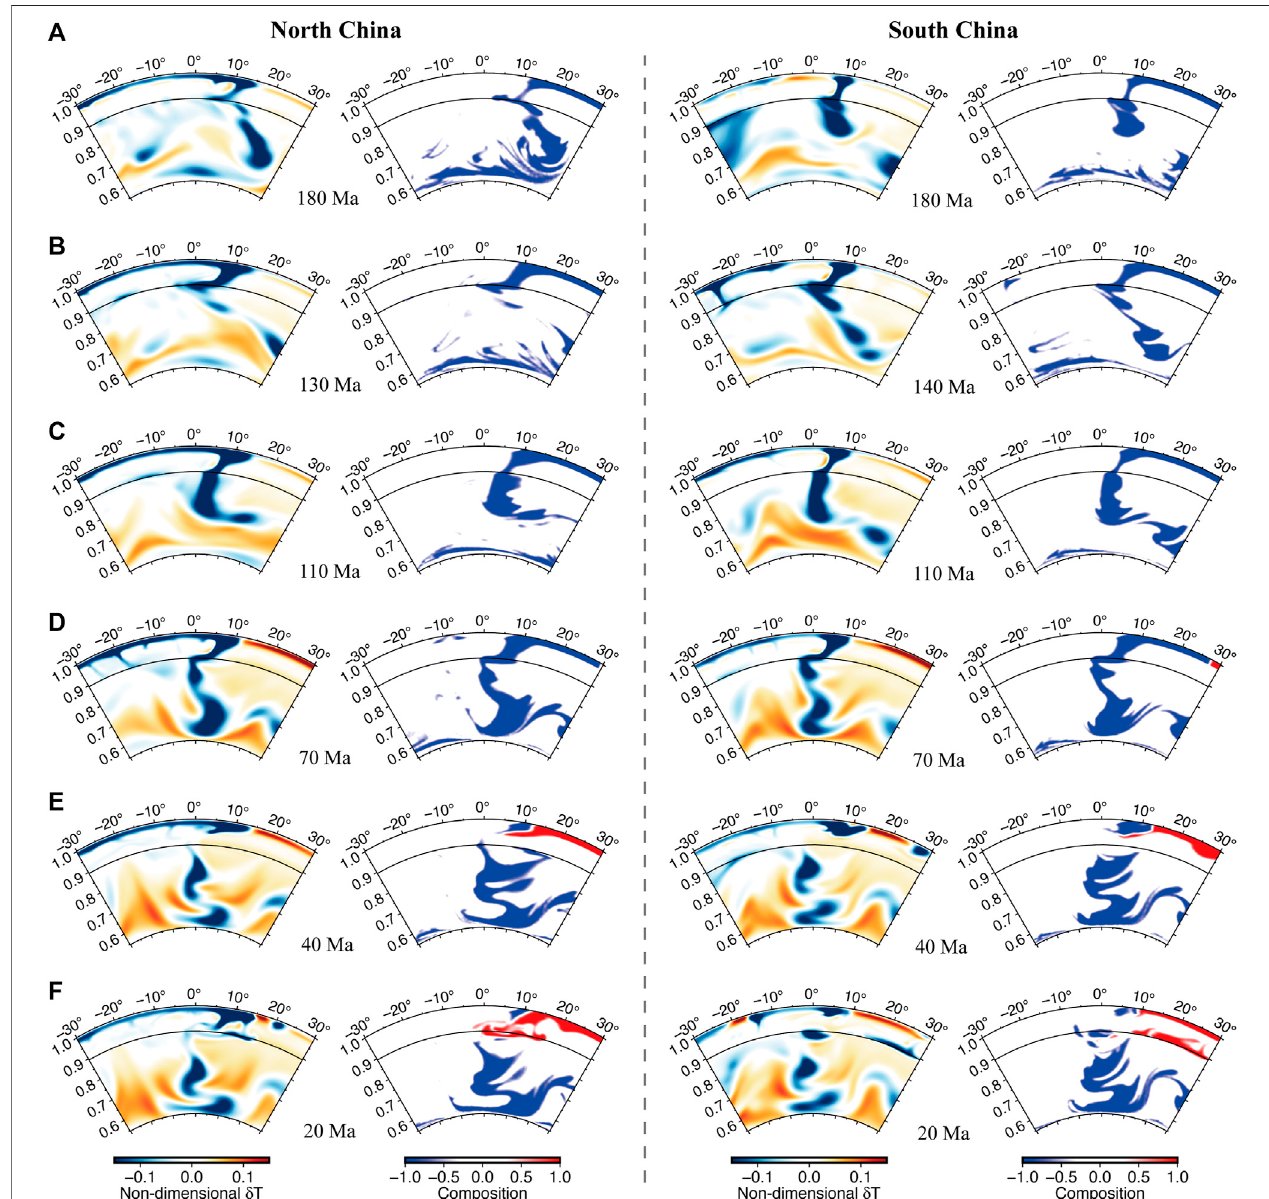
FIGURE 4 | Slab structures of the Izanagi-Paci fi c plate beneath the North China Craton (left columns) and the South China Block (right columns) at some time snapshots from case 1. In (A – F) , the left and right columns are cross-sections of the residual temperature and composition fi elds across the NCC and the SCB, respectively. The fully-time evolution of the slab structures for the NCC and the SCB are provided in Supplementary Figures S3, S4 , respectively.